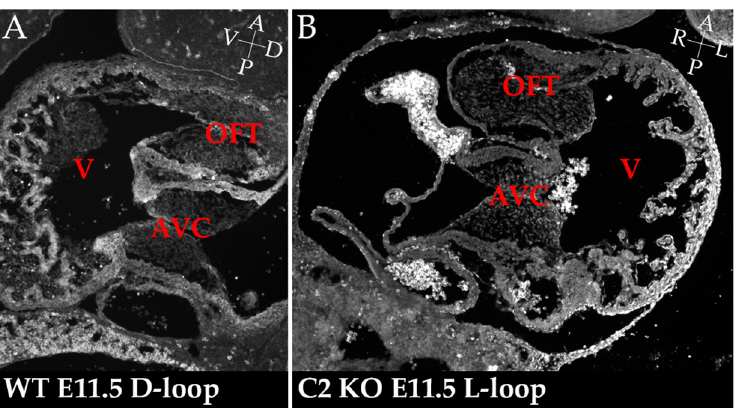
Figure 3. Incorrectly looped hearts in Cerl2 mutant embryos. Sagittal section of a wild-type (WT) ( A ) and coronal section of Cerl2 mutant ( B ) hearts after looping stages, at developmental stage E11.5. These sections made in different orientations (sagittal and coronal) show exactly the same anatomical features: the common ventricular chamber (V) and span the outflow tract (OFT) and atrioventricular canal (AVC) cushions of E11.5 mouse embryos. This shows that in the WT there was a correct rightward (D-loop) ( A ), and in the mutant the looping occurred at a different angle, a leftward one (L-Loop) ( B ). Embryo axes coordinates are present in panels A and B , in white letters: A: anterior; P: posterior; R: Right, L: Left; D: Dorsal; V: Ventral.